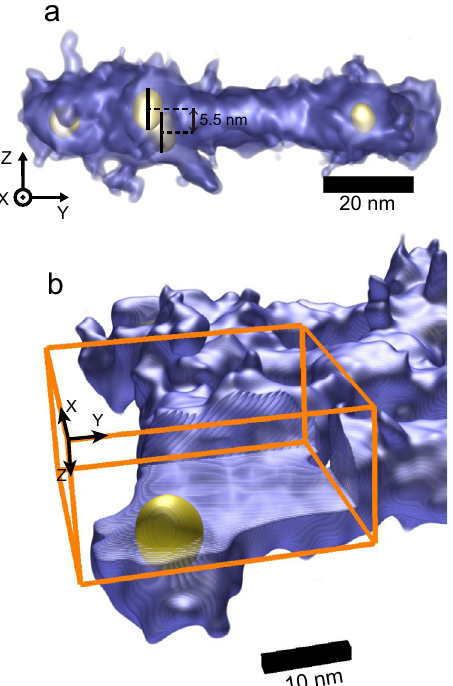
Fig.2|Sub-volumeptychographictomography.a 3DrenderingalongtheX-axis. b 3Drenderingofacore-shellstructureformedbyagoldnanoparticle(yellow)and DNA strands (blue), which is hidden in the orange